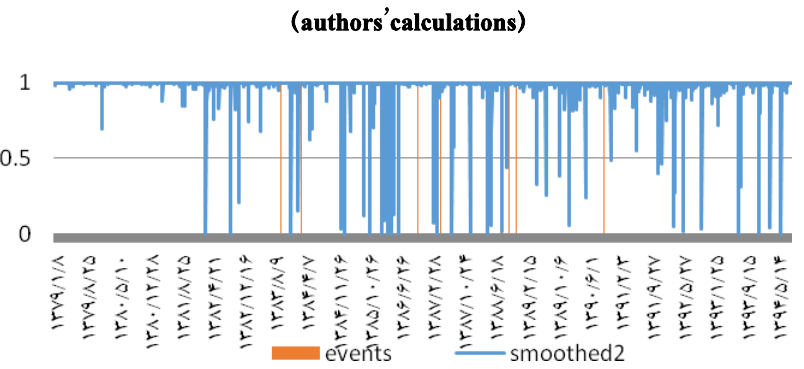
Figure 3: Trend of the possibility of regime change smoothed for the second regime (authors’calculations)